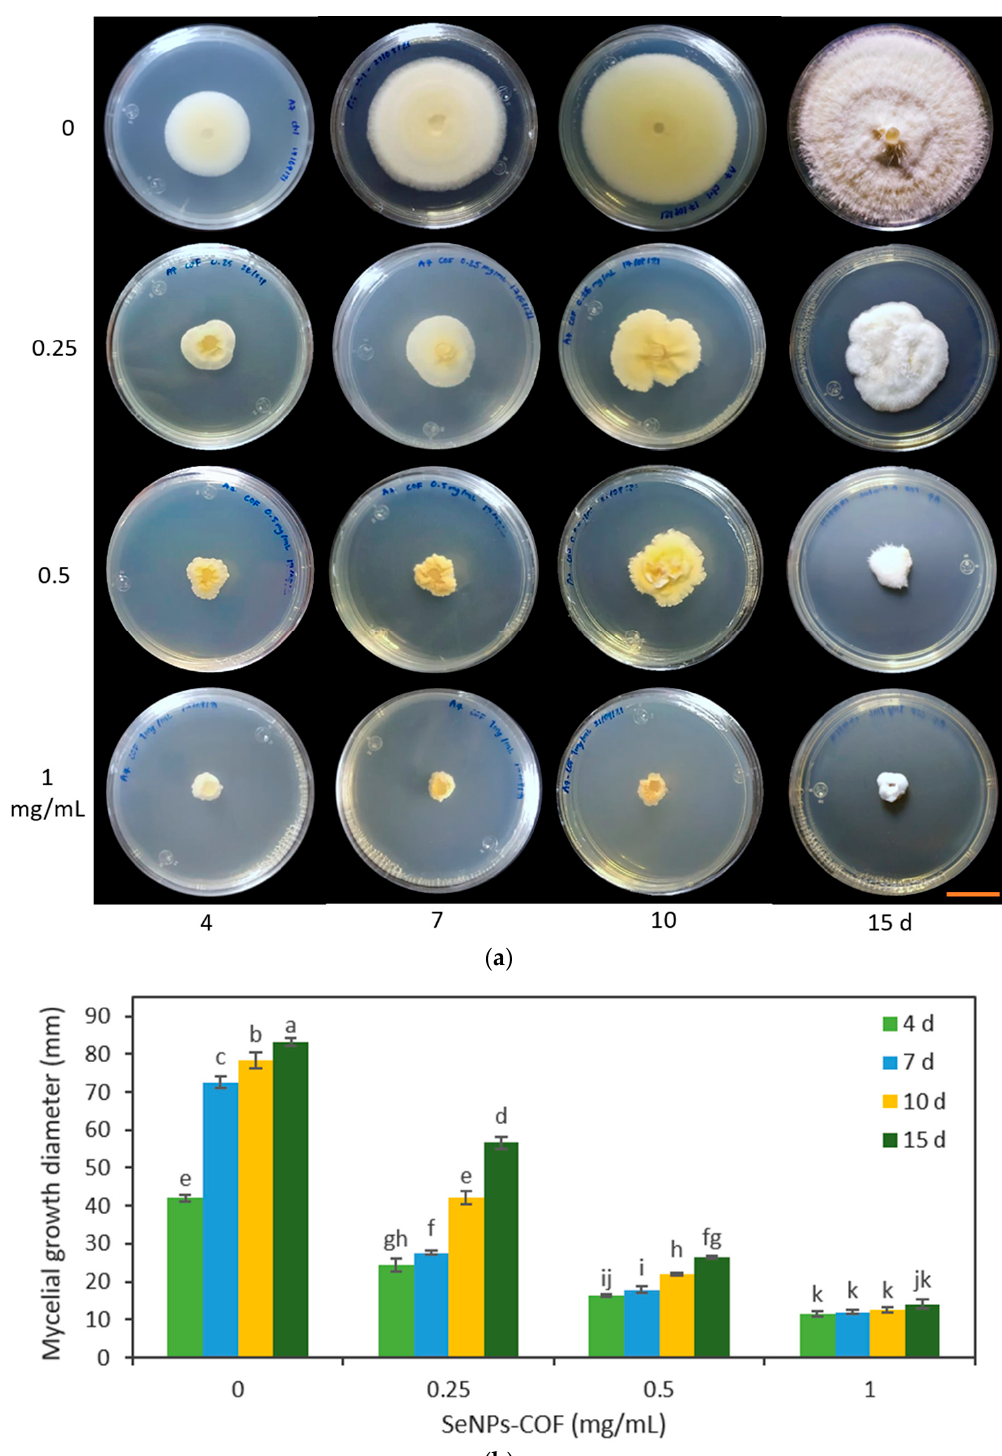
Figure 10. Effect of different concentrations of SeNPs synthesized with A. glaucum (AGL) extracts against C. gloeosporioides . ( a ) Representative photograph of the antifungal activity test under differ- ent concentrations over time. SeNPs were applied at 0.25, 0.5, and 1 mg/mL. The scale bar is 2.5 cm. ( b ) Mean comparison of the effect of the SeNPs synthesized with extracts of A. glaucum against C. gloeosporioides at different concentrations. Mean values ± ee. Different letters indicate statistically significant differences according to Duncan’s test ( α = 0.05), p < 0.0001.